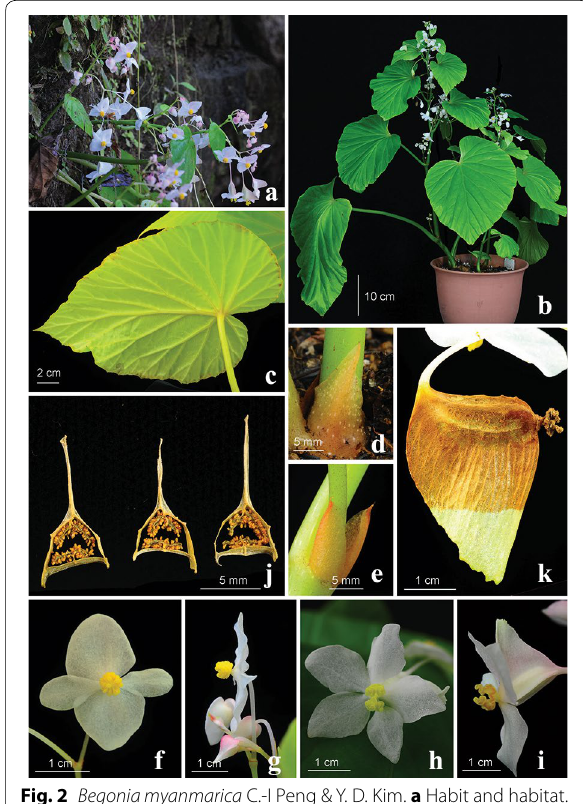
Fig. 2 Begonia myanmarica C.‑I Peng & Y. D. Kim. a Habit and habitat. b Cultivated plant at anthesis. c Leaf abaxial view. d Stipule. e Bract. f Male flower, face view. g Male flower, side view. h Female flower, face view. i Female flower, side view. j Cross section of ovaries. k